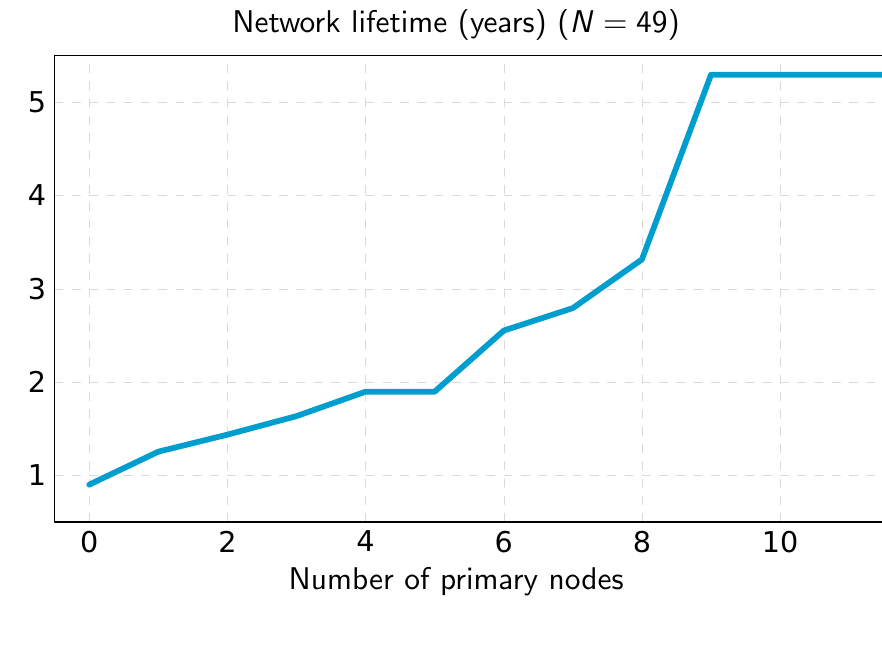
Figure 4. Network lifetime as a function of the number of primaries for the network of Figure